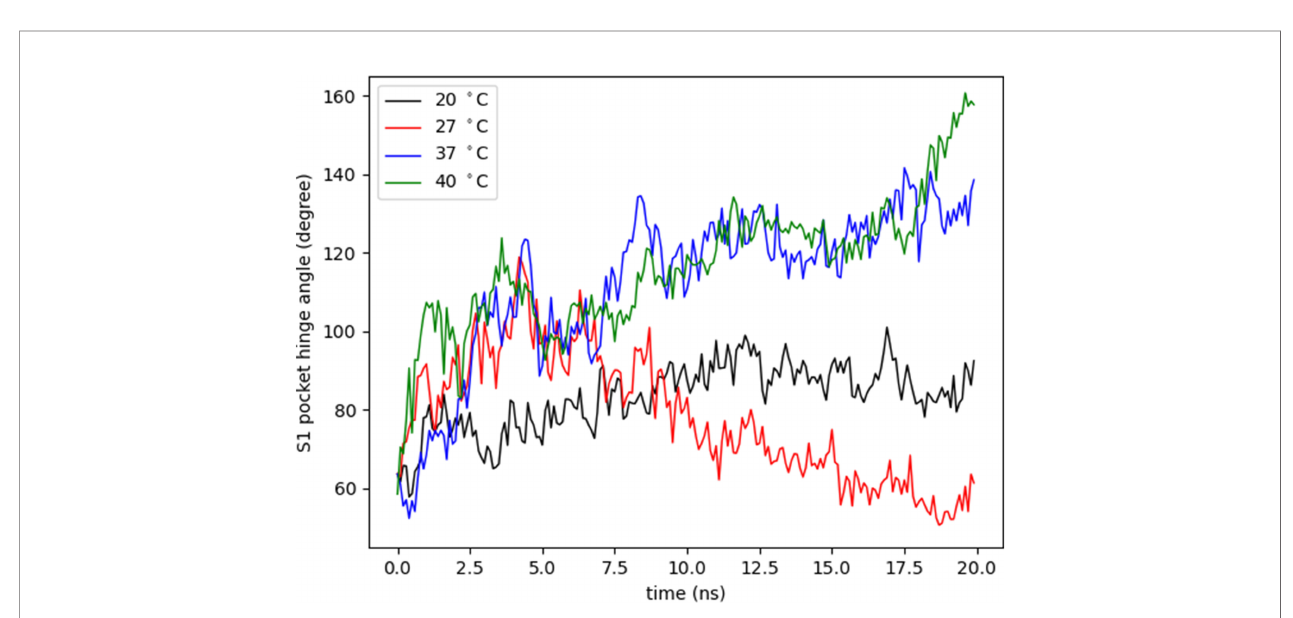
FIGURE 9 | Variation of S1 pocket hinge angle. The S1 pocket hinge angle (degree) was measured as the angle between CA atoms of residues Arg389, Arg399, and Ser405 to describe the opening of region 5 at different temperatures (°C) during 20 nanoseconds (ns).